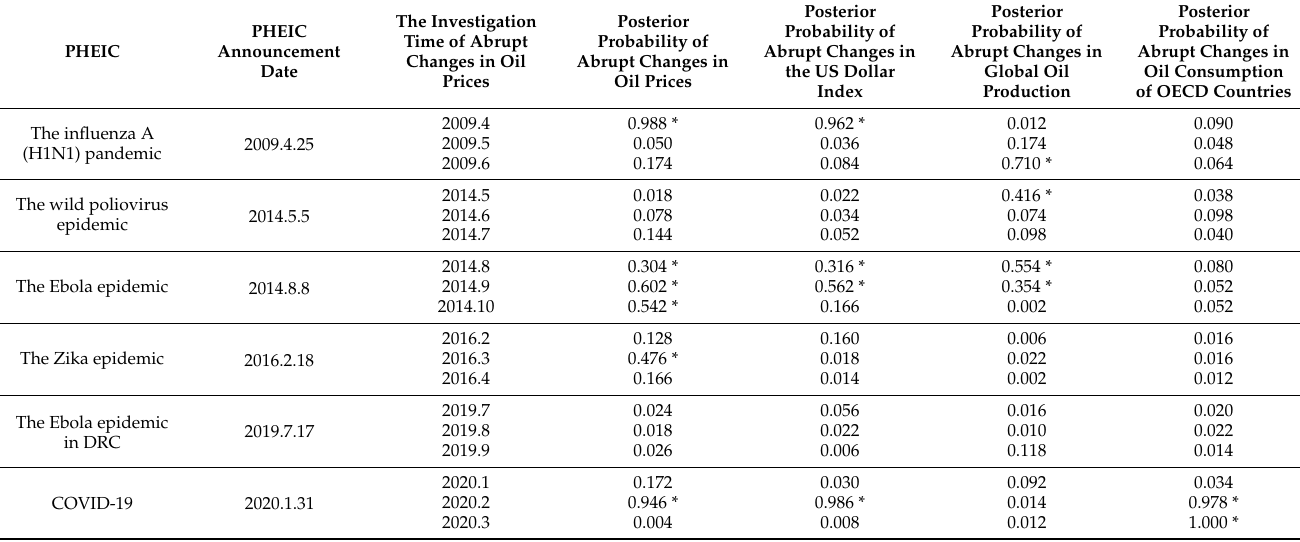
Table A1. Changes in WTI oil price, US dollar index, global oil production, and oil consumption of OECD countries during